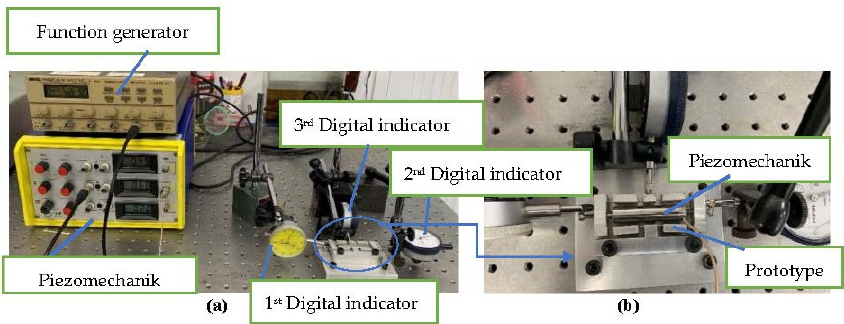
( b ) Figure 9. The optimal results. ( a ) The optimal result of displacement; ( b ) The optimal result of stress. 4.6. Verified Experiment The optimal parameters x 1 y 1 z 1 t 1 w 1 were utilized to manufacture a prototype bridge- type compliant mechanism. The mechanism was fabricated by the use of an electrical wire